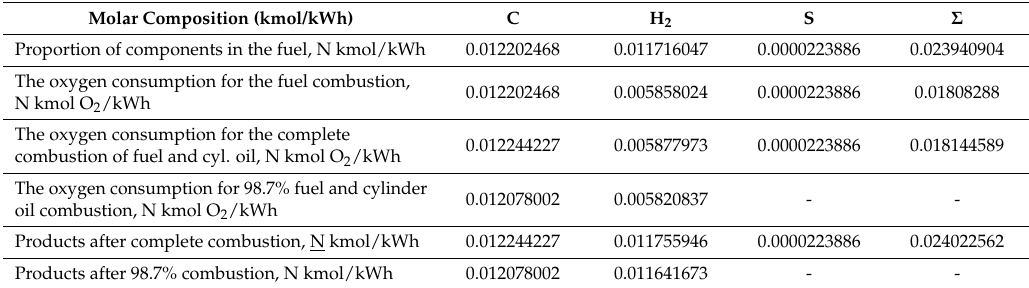
Table 5. Fuel composition and stoichiometric oxygen consumption for fuel and cylinder oil combustion at 100% SMCR, ISO standard conditions.